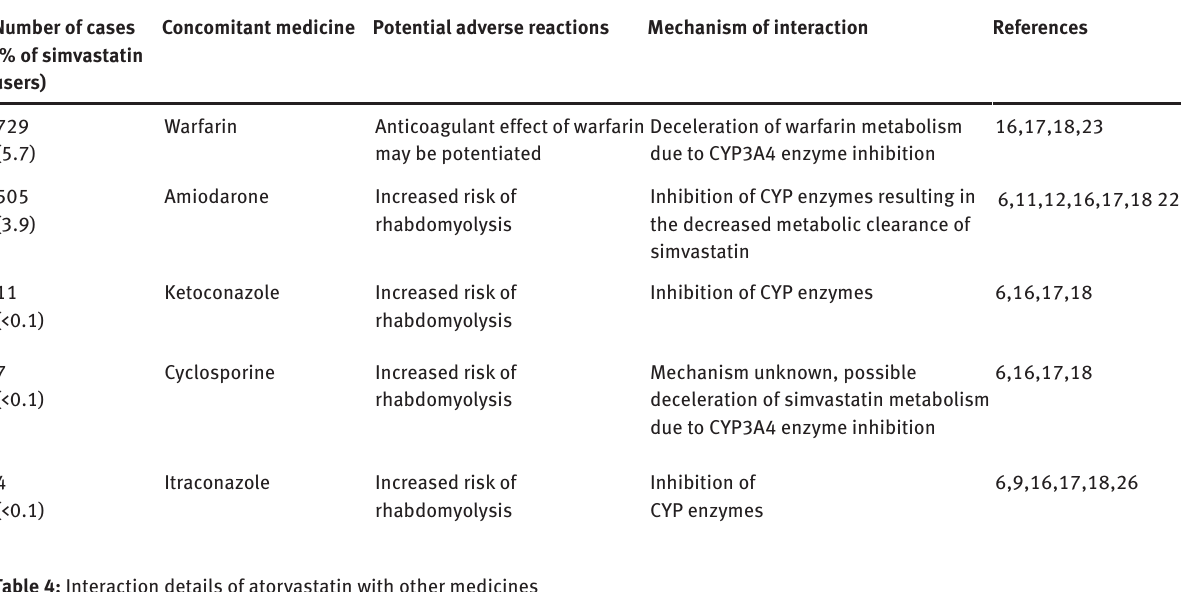
Table 4: Interaction details of atorvastatin with other medicines